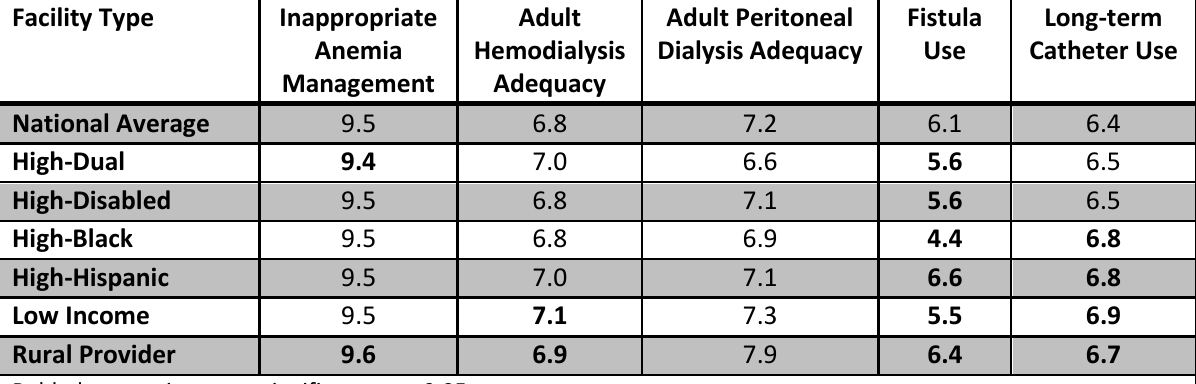
Table 11.6a: Measure Scores for